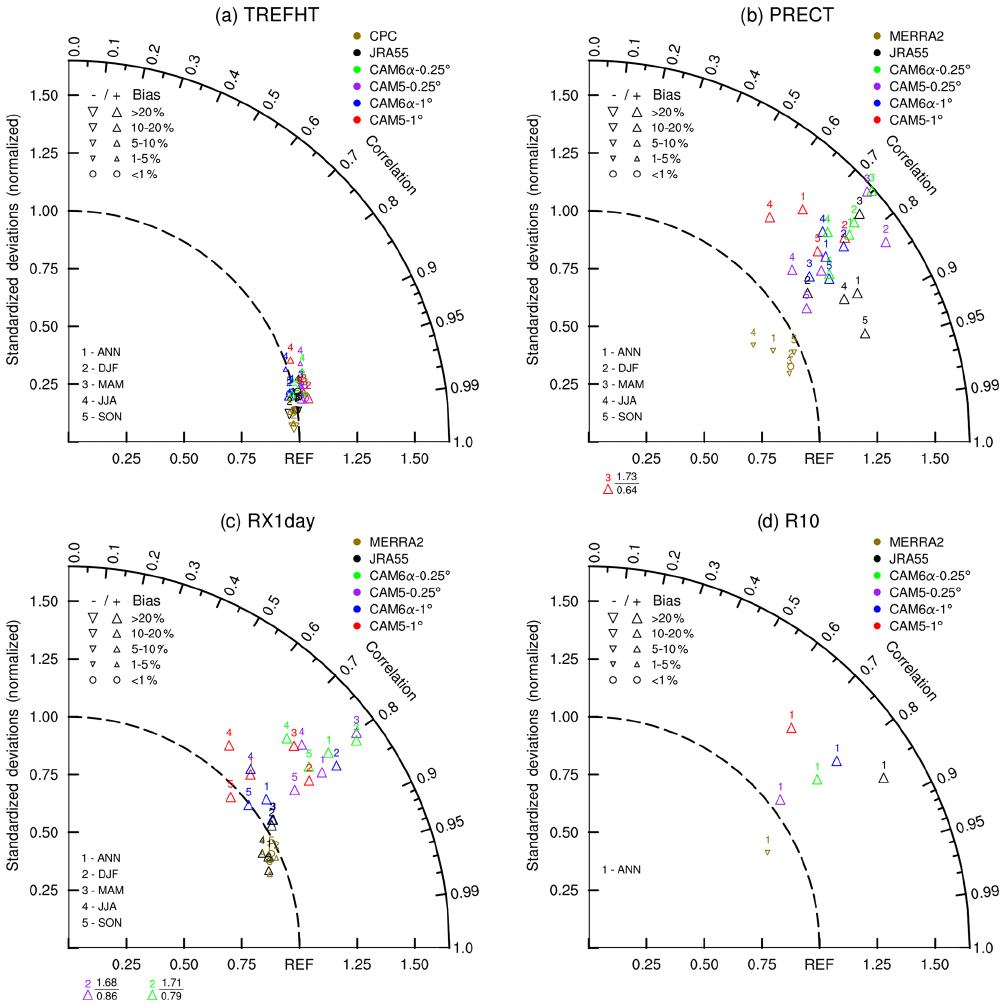
Figure 5. Taylor diagrams for (a) surface air temperature, (b) precipitation, (c) RX1day (the maximum daily precipitation during each month of a year; mmd − 1 ) and (d) R10 (number of days with precipitation more than 10mm; units: days). These two extreme indices are suggested by the Expert Team for Climate Change Detection and Indices (Zhang et al., 2011). Note that R10, by design, only has an annual mean but not a seasonal mean. Spatial correlations and normalized RMS (root mean square) are calculated for ANN (1, annual), DJF (2, winter), MAM (3, spring), JJA (4, summer) and SON (5, fall). APHRODITE is used as the benchmark over Asia for 1980–2004. All the data were interpolated to 1 ◦